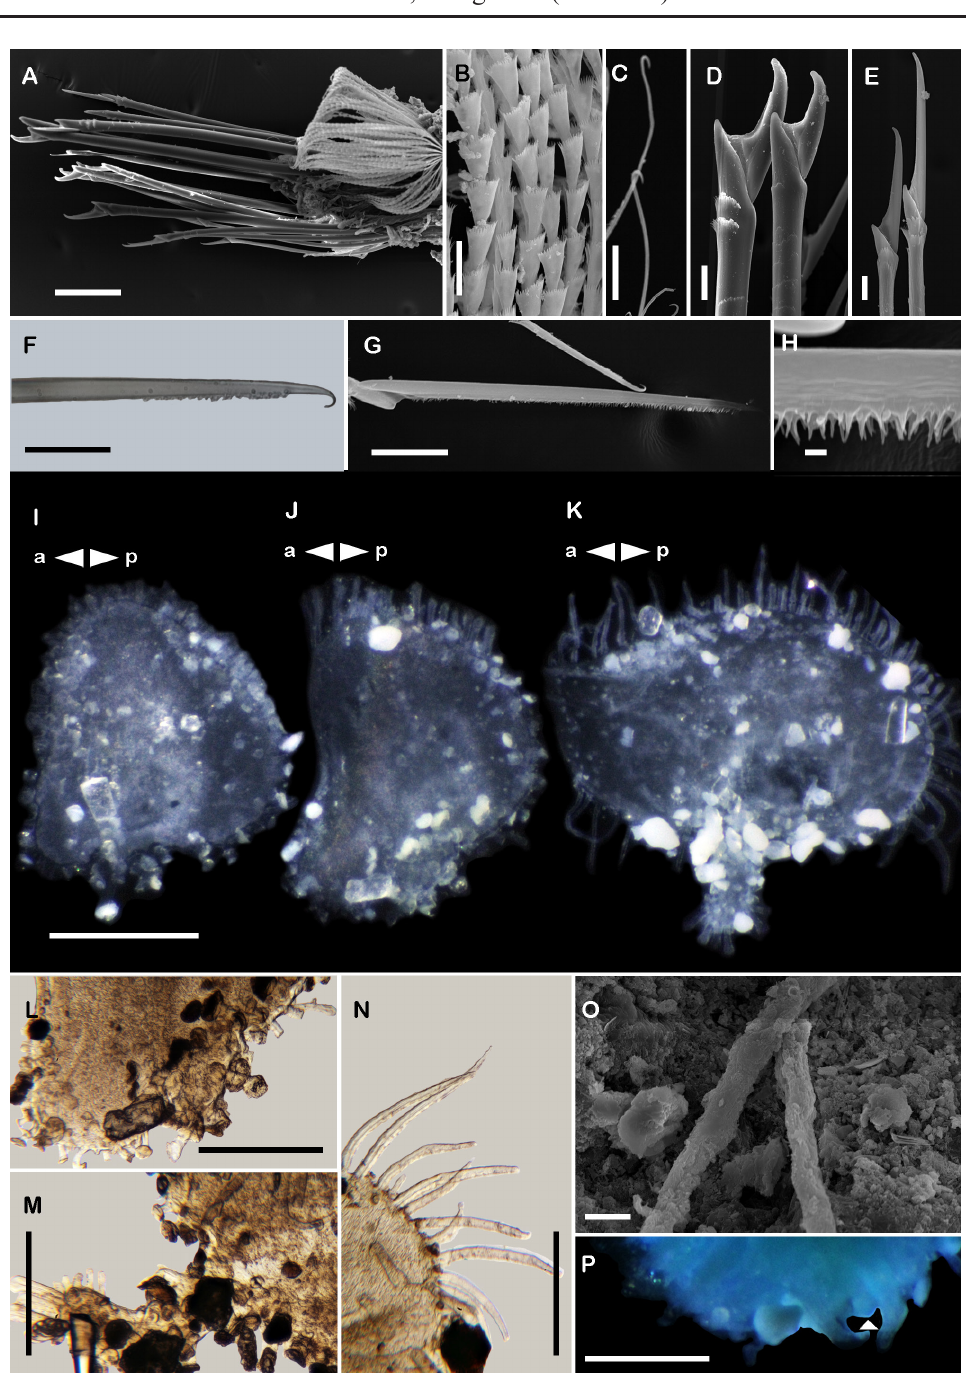
Fig. 20. Pelogenia capitata sp. nov. A–E, G–H, O. SEM micrographs. A–H . Additional material (ECOSUR-P3227). I–P . Holotype (ECOSUR 291). A . Parapodium from segment 26. B . Notochaetae from same. C . Distal section from same. D . Unit A and B. E . Unit D. F . Unit A from segment II. G . SEM micrograph of unit A from segment II. H . Detail of basal side of the blade from G. I . First right elytron. J . Second right elytron. K . Posterior right elytron. L . Median process from J. M . Median process from K. N . Posterior margin from K. O . Surface of posterior elytron, flat papillae, pedunculate papillae with flat tip and long dendritic papillae. P . Posterior end, ventral view, arrowhead indicates pygidium. Abbreviations: a = anterior; p = posterior. Scale bars: A = 100 μm; B–C, E, O = 10 μm; D, F–G = 20 μm; H = 1 μm; I–K, P = 500 μm; L–N =